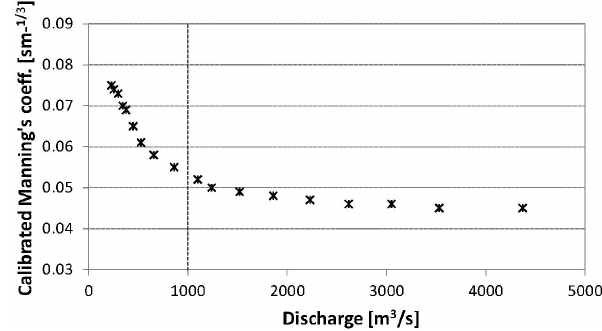
Fig. 3. Variation of calibrated Manning’s roughness coefficients ( n ) at the Cremona cross-section in relation to different hydraulic condition (river water